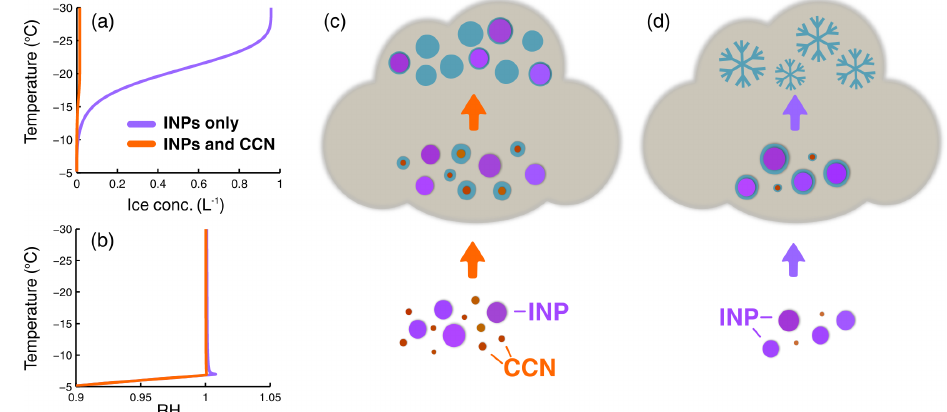
Figure 3. A schematic diagram demonstrating the suppression of ice formation caused by the presence of CCN. (c) The INPs and CCN (high CCN) case where water vapour condenses onto the CCN in preference to the INPs preventing them from activating and freezing. (d) The “low CCN” case where, without the CCN, the max supersaturation ( (a) purple line) can rise high enough for INPs to activate and then freeze. (a) Relative humidity and (b) ice concentration with decreasing temperature for the two cases. The “low CCN” case (purple lines) contained 1L − 1 300nm K-feldspar and 50cm − 3 60nm ammonium sulphate particles. The “high CCN” case (orange lines) contained 1L − 1 300nm K-feldspar and 2000cm − 3 200nm ammonium sulphate. Initial conditions for the two simulations are the same as those detailed in Table 2. An updraft velocity of 0.5ms − 1 was used in both cases. The criteria for heterogeneous freezing was “activated only”.